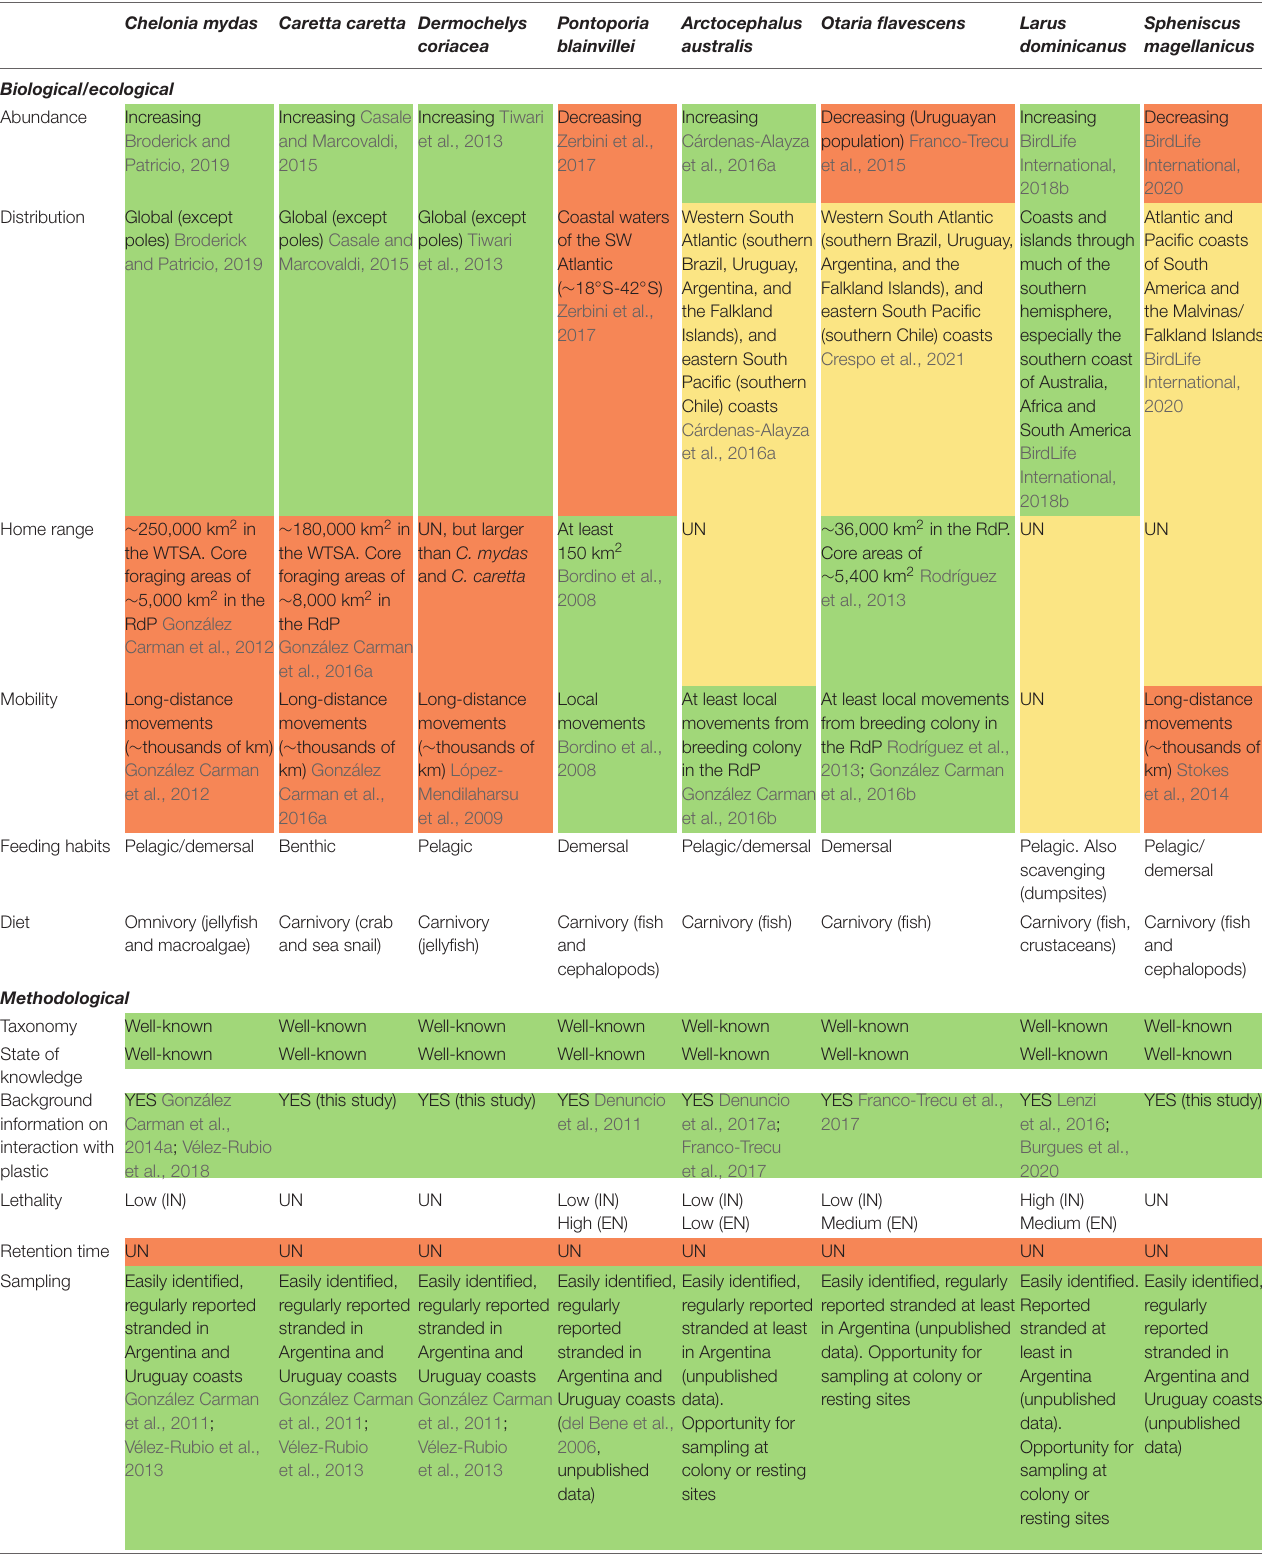
TABLE 3 | Biological/ecological, methodological, and conservation attributes of species selected to be used as indicators of plastic pollution in the Río de la Plata estuarine area. Colors denote that attributes are suitable (green), vague (yellow), or unsuitable (red) for indicator